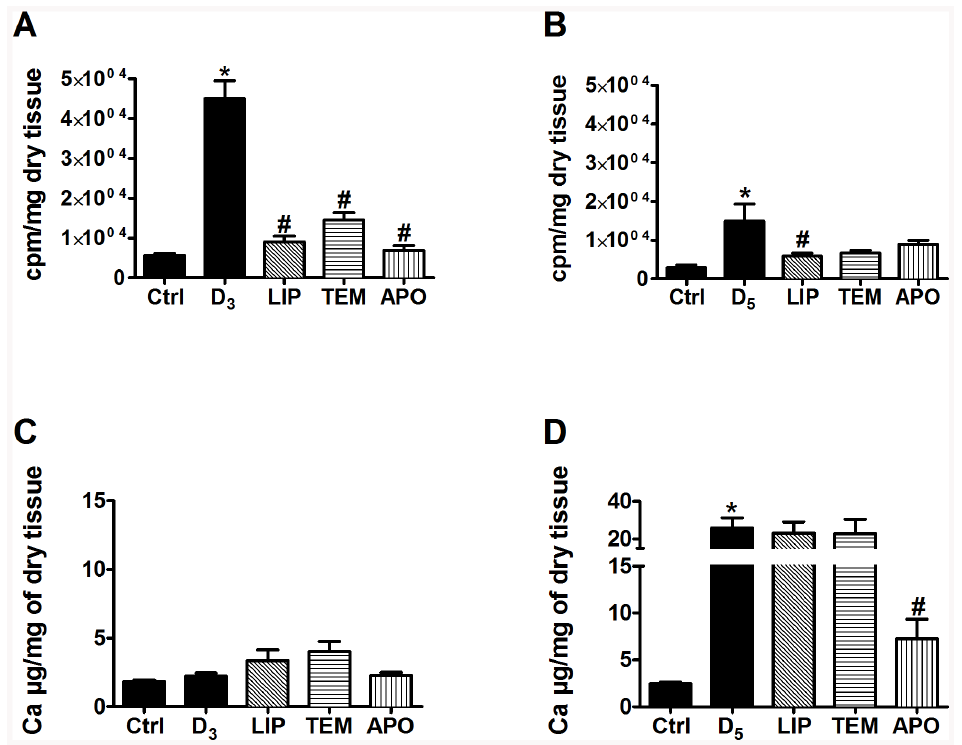
Figure 5. Impact of anti-oxidants treatment on femoral arteries. Lucigenin chemiluminescence after a 3-week treatment (A) and 5-week treatment (B). Calcium content after a 3-week treatment (C) and 5-week treatment (D). LIP: alpha-lipoı¨c acid (100 mg. kg-1. day-1); TEM: 4 hydroxy- tempol (20 mg. kg-1. day-1); APO: apocynin (2,5 mg. kg-1. day-1). (* p , 0.05 vs Ctrl) ( # p , 0.05 vs D).